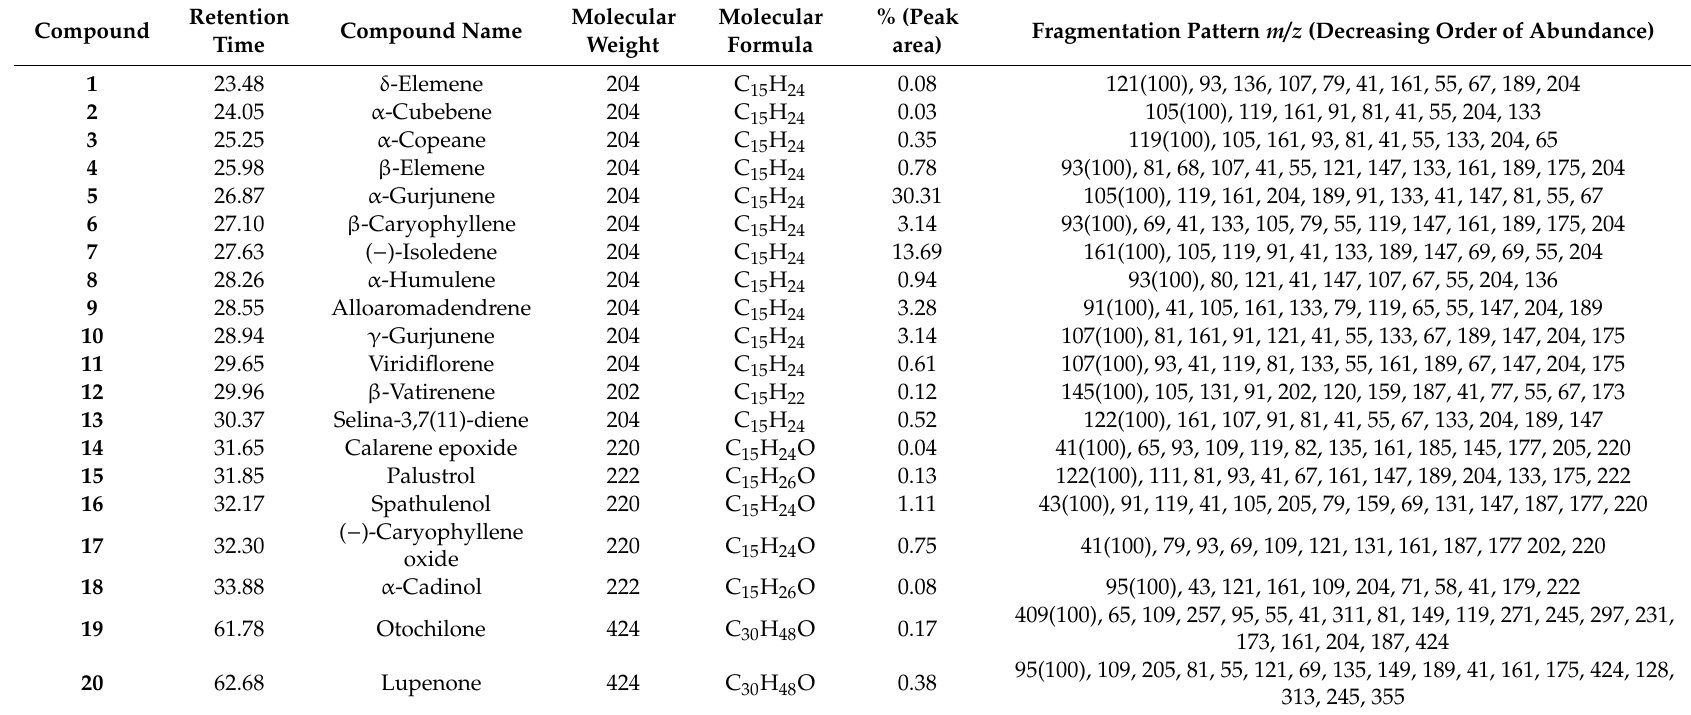
Table 2. Principal compound profiling of oleo-resin of D. alatus by